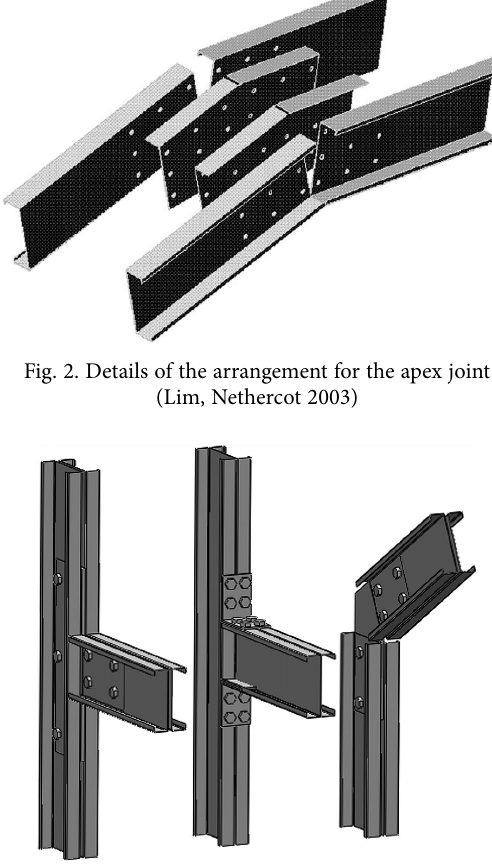
Fig. 3. Beam-to-column bolted connections. From the left: 90 degree connection using gusset plate and angles, 45 degree eave connection with gusset plate